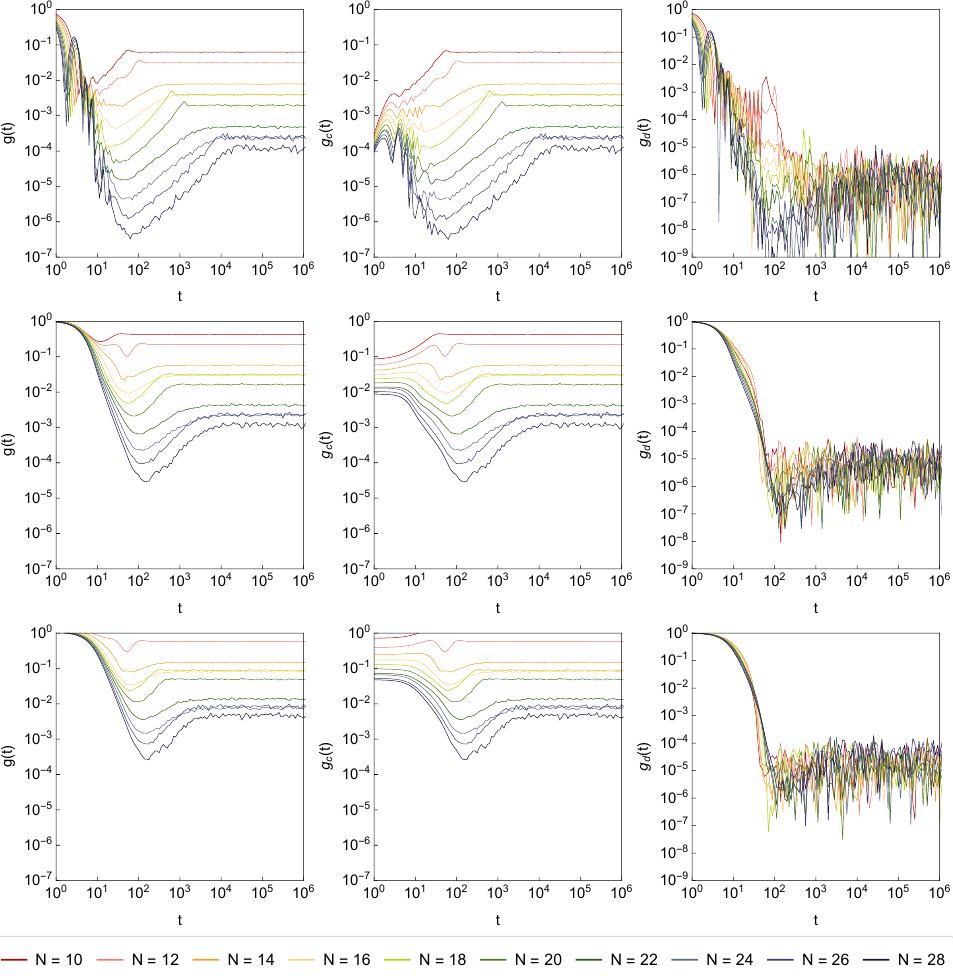
Figure 6 . The \spectral form factors" g ( t ), g c ( t ) and g d ( t ) in the supersymmetric SYK model, treating the supercharge matrix as the Hamiltonian, with J N =1 = 1, (cid:12) = 0 ; 5 ; 10